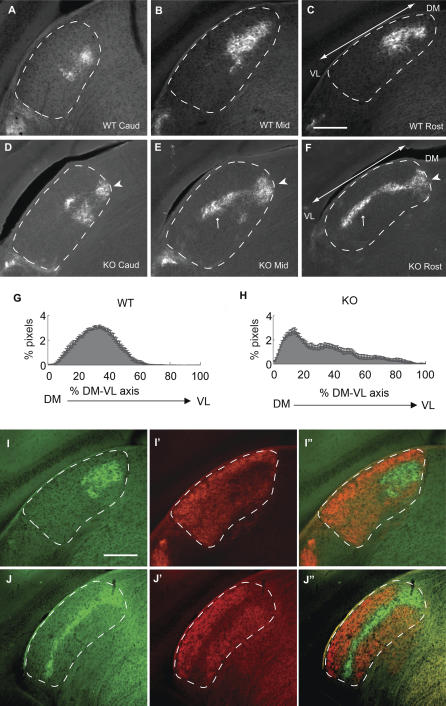
The Ipsilateral Retinogeniculate Projection Is Altered in Ten_m3 KO Mice(A–C) A caudal to rostral series of coronal sections through the dLGN of a 3.5-wk-old WT mouse showing the normal distribution of ipsilateral terminals in the dLGN following transport of fluorescent CTB from the eye. Ipsilateral projections consistently target the dorsomedial (DM) region at all rostrocaudal levels of the nucleus.(D–F) As for (A–C), but from a Ten_m3 KO mouse. Marked alterations in the targeting of ipsilateral projections are clearly visible. In caudal sections (D), the label is confined to the DM region of the nucleus similar to WTs, but, unlike WTs, the label is expanded dorsomedially such that it abuts the border of the nucleus (arrowhead). In the centre of the nucleus (E), the projection expands both towards the ventrolateral (VL) region of the nucleus (small arrow) and the dorsomedial (arrowhead). This is more obvious in the rostral region of the nucleus (F) where the VL tail approaches the border of the nucleus. Note that although the ipsilateral region is elongated in KOs, it is also narrower. The double-headed arrows indicate the DM-VL axis along which the distribution of label was quantified as shown in (G) and (H).(G and H) Plots of the mean ± standard error of the mean (s.e.m.) distribution of the ipsilateral projection along the DV-ML axis in five WT (G) and five KO (H) animals. In WTs, a smooth bell-shaped curve is seen that rises to peak around 30%–40% of the DV-ML axis and decreases to low values by around 60% of the axis. In KOs, the curve rises sharply to peak at around 10% of the DV-ML axis (DM expansion), but the tail of the distribution declines much more gradually with some label extending to 100% of the DM-VL axis (VL expansion). The distributions are significantly different (p < 0.0001, Kolmogorov-Smirnov test).(I–J") Relationship of ipsilateral and contralateral projections in WT (I–I") and Ten_m3 KO (J–J") mice. Coronal sections through the dLGN following intraocular injections of red or green CTB into the right or left eye, respectively. The images (I–I″) and (J–J″) are photomicrographs of the same section showing, respectively, the ipsilateral label (green), contralateral label (red), and a merged image of the two for each section. In WTs, the ipsilateral projection is confined to a patch in the dorsomedial quadrant of the dLGN (I) as above, whereas the contralateral label projection avoids this region and fills the rest of the dLGN (I′). The relationship between the ipsilateral and contralateral projections is seen more clearly in the merged image (I″). In Ten_m3 KOs, the ipsilateral projection (J) is dramatically elongated along the DM-VL axis of the dLGN as above. The contralateral projection (J′) avoids the regions occupied by the ipsilateral terminals (J″) even though they now map to regions usually occupied by contralateral terminals. The borders of the dLGN are indicated by the dashed line in (A–F) and (I–J″). Dorsal is to the top, and lateral to the left. Scale bar indicates 200 μm, which applies to all micrographs